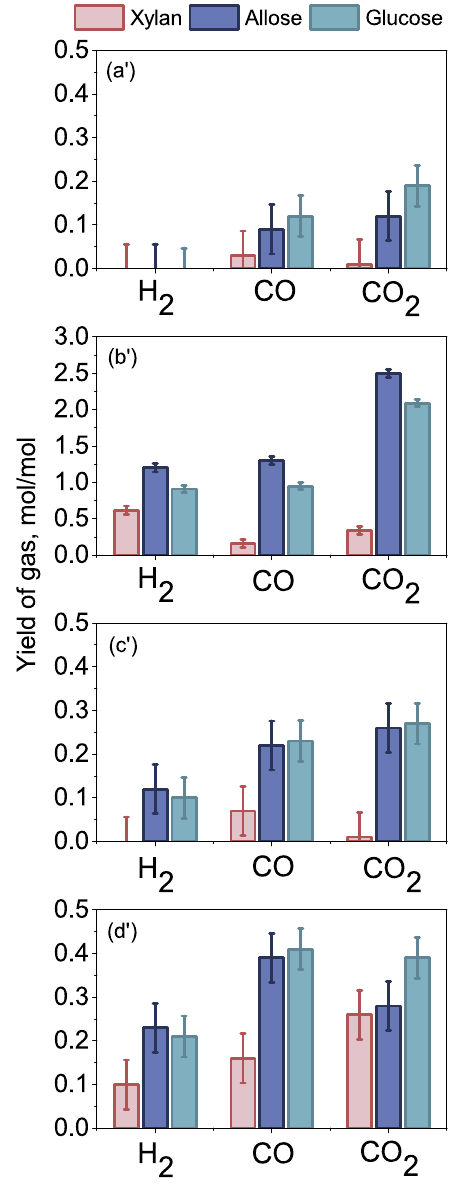
Fig. 4 | Product distribution from the pyrolysis of C5 xylan, C6 allose and C6 glucose at 400°C. Panels a and a ’ for the selectivity and yield of furfural, and the yields ofindividual gases from the blank tests, respectively. Panels b and b ’ for the respective results from the PdO catalyst. Panels c and c ’ for the respective results